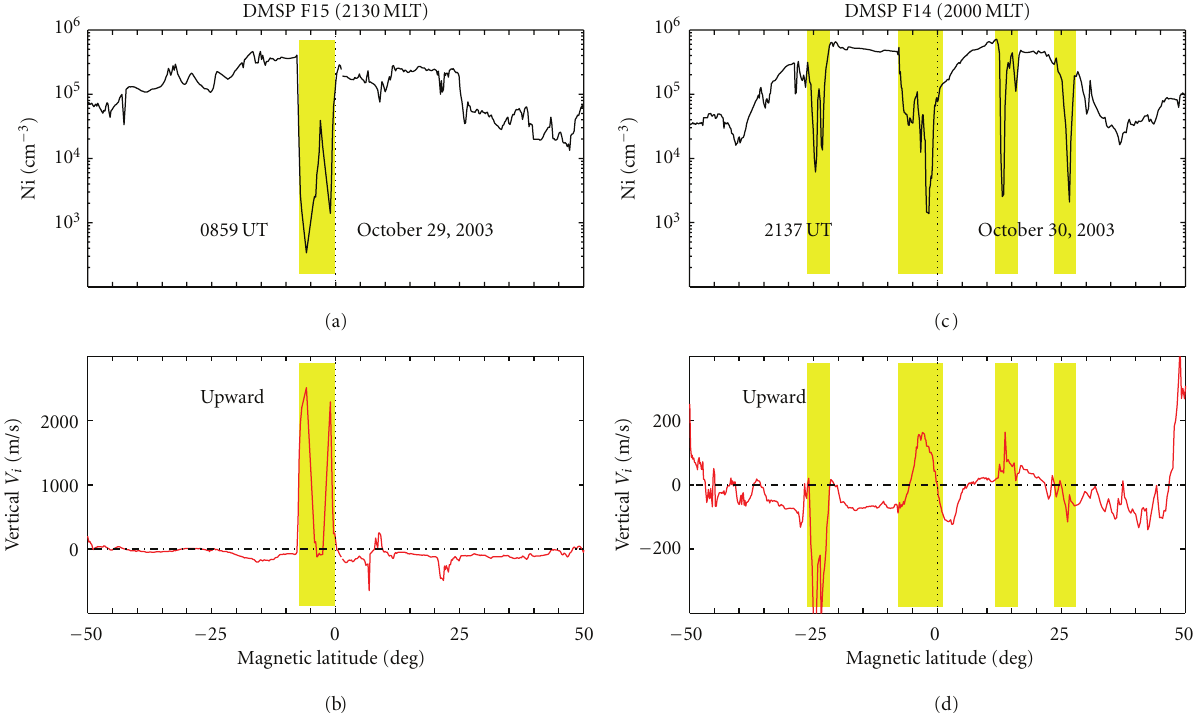
Figure 4: Latitudinal structures of ionospheric ion density and vertical ion drift associated with equatorial plasma bubbles. The shaded regions indicate ion density depletions (plasma